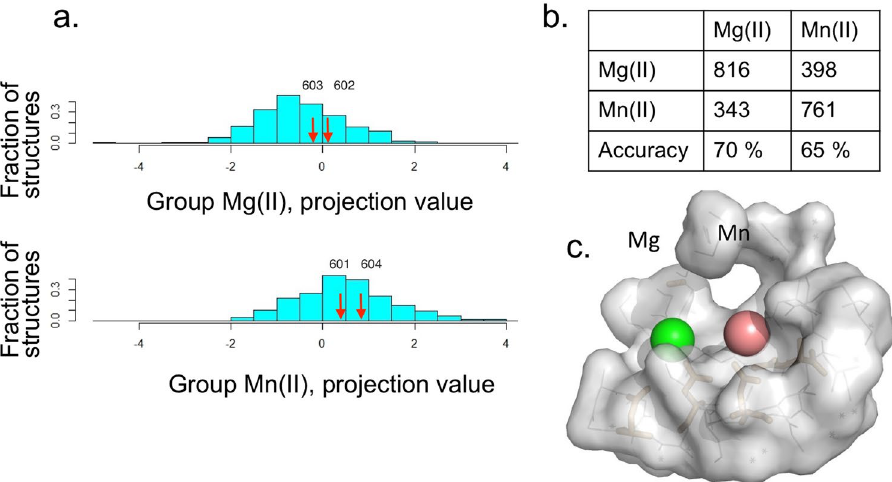
Figure 5. LDA analysis of the divalent metal binding site. ( a ) Histogram of projection values of 685 bound Mg(II) molecules (top) and 685 bound Mn(II) molecules (bottom) on the LDA vector w * . The separation between the two classes is evident: Mg(II) tends to have smaller (negative) projection values on w * , while Mn(II) tends to have larger (positive) projection values. Arrows schematically show the value of the projection of every feature vector on the LDA. Posterior probabilities are derived accordingly. ( b ) The confusion matrix for the LDA classifier using Leave-One-Out (LOO) cross-validation on the 2318 atoms. The columns represent the true classification and the rows are the LDA predictions. Accuracy (70% for Mg(II) and 65% for Mn(II)) should be compared against the baseline of a random guess (accuracy of 0.5). ( c ) Model of the active site of the T7 primase RNA polymerase domain containing Mg(II) and Mn(II) (based on the structure of the T7 primase domain of the gene 4 product, pdb code: 1 nui).